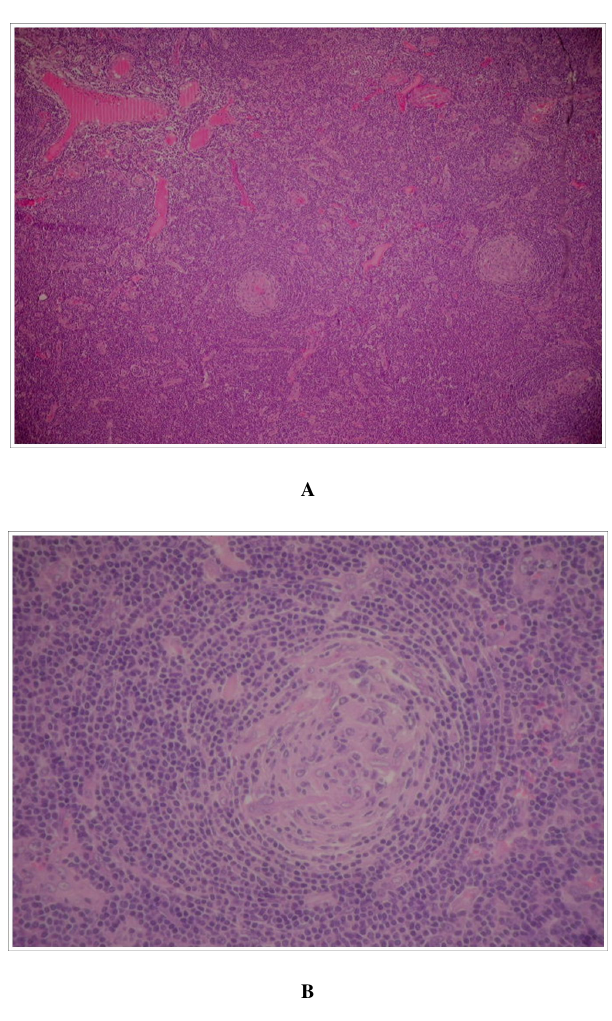
FIGURE 3. Histopathologic examination showing angiofollicular hyperplasia. (A) The characteristic histological pattern is produced by a great number of lymphoid follicles regularly distributed on a background of lymphocytes. (B) A detail of the enlarged lymphoid follicle shows that the central vessels present thick walls and that the endothelial cells are